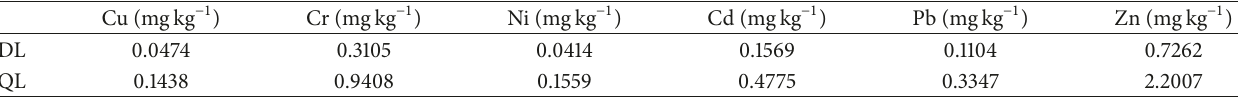
Table 1: Detection limits (DL) and limits quantification (QL) determined for elements quantified by atomic